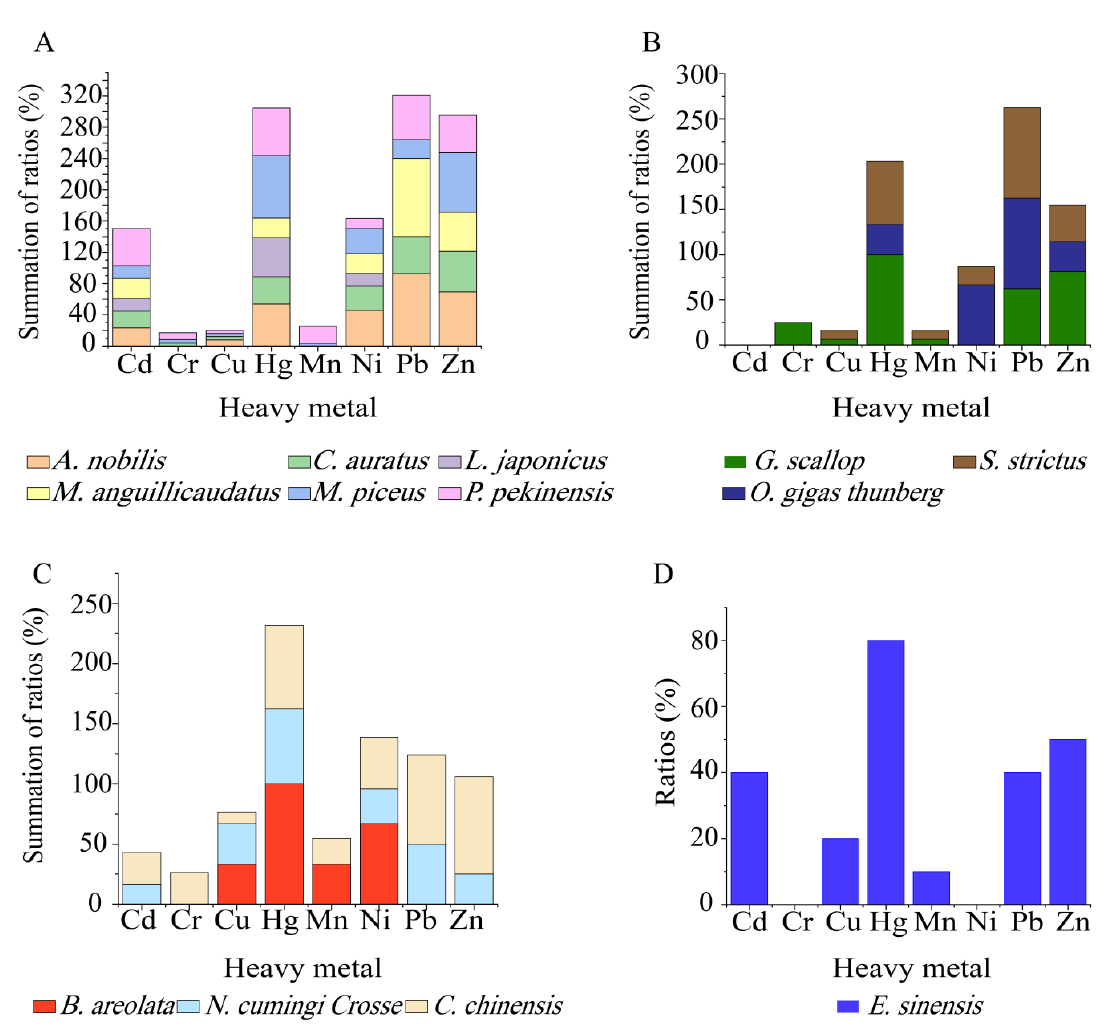
Figure 7. Heavy metal tolerance profiles of the V. cholerae isolates recovered from the 13 species of aquatic food animals. ( A – D ): the species of fish, shellfish, snails, and crab, respectively.